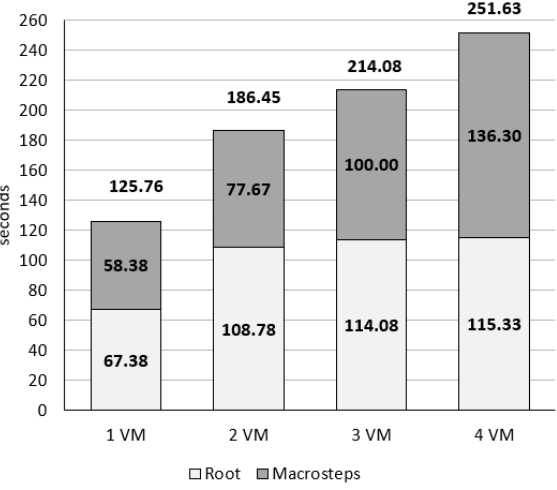
Figure 8. Average time in seconds to traverse one execution path with 1 to 4 VMs and